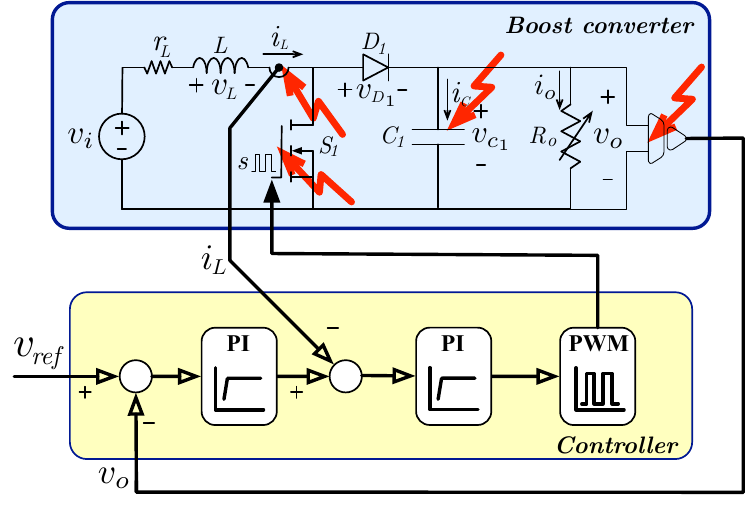
Figure 4. Boost converter and injected